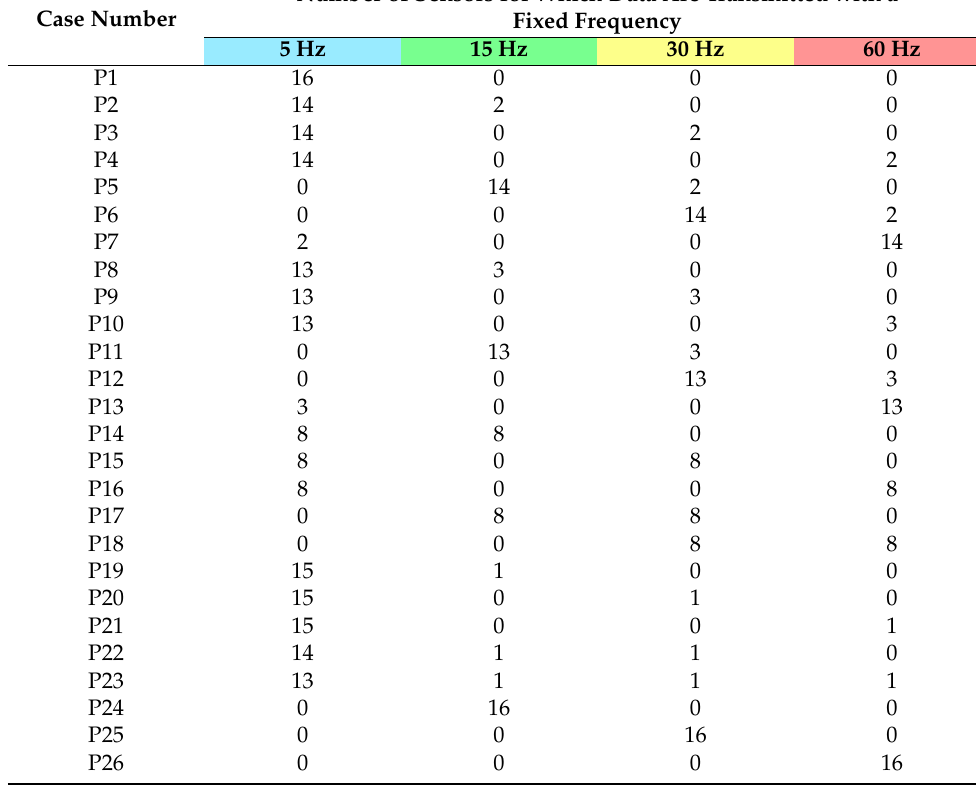
Table 2. Configurations of defined measurement